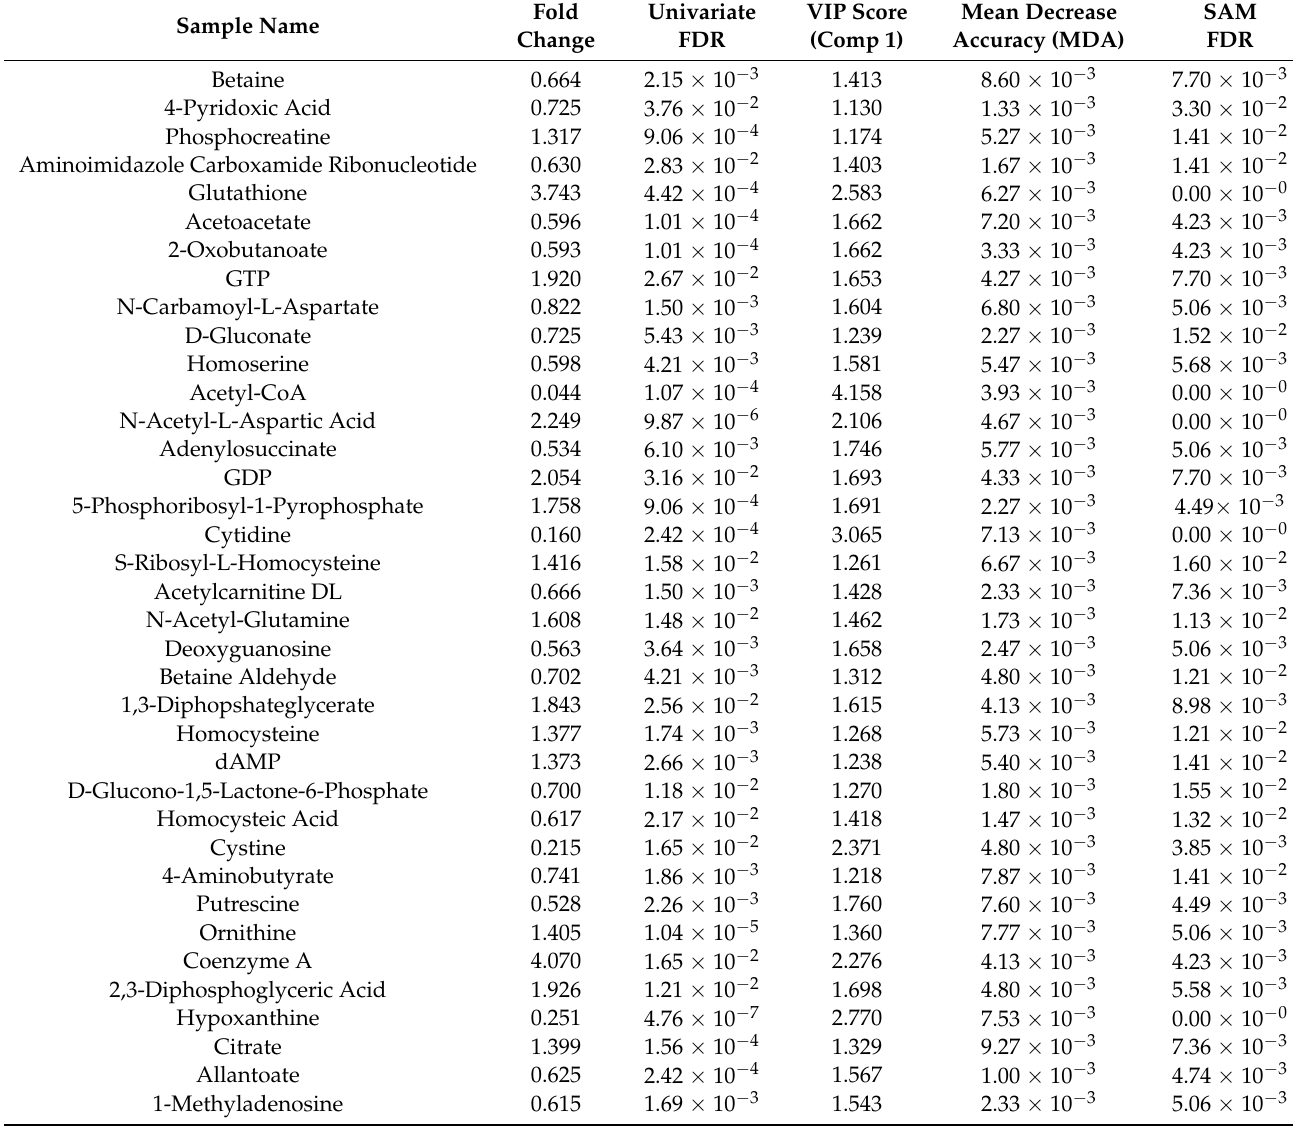
Table 3. Discriminant metabolites identified after deletion of Drp1. Test statistics calculated for significantly altered